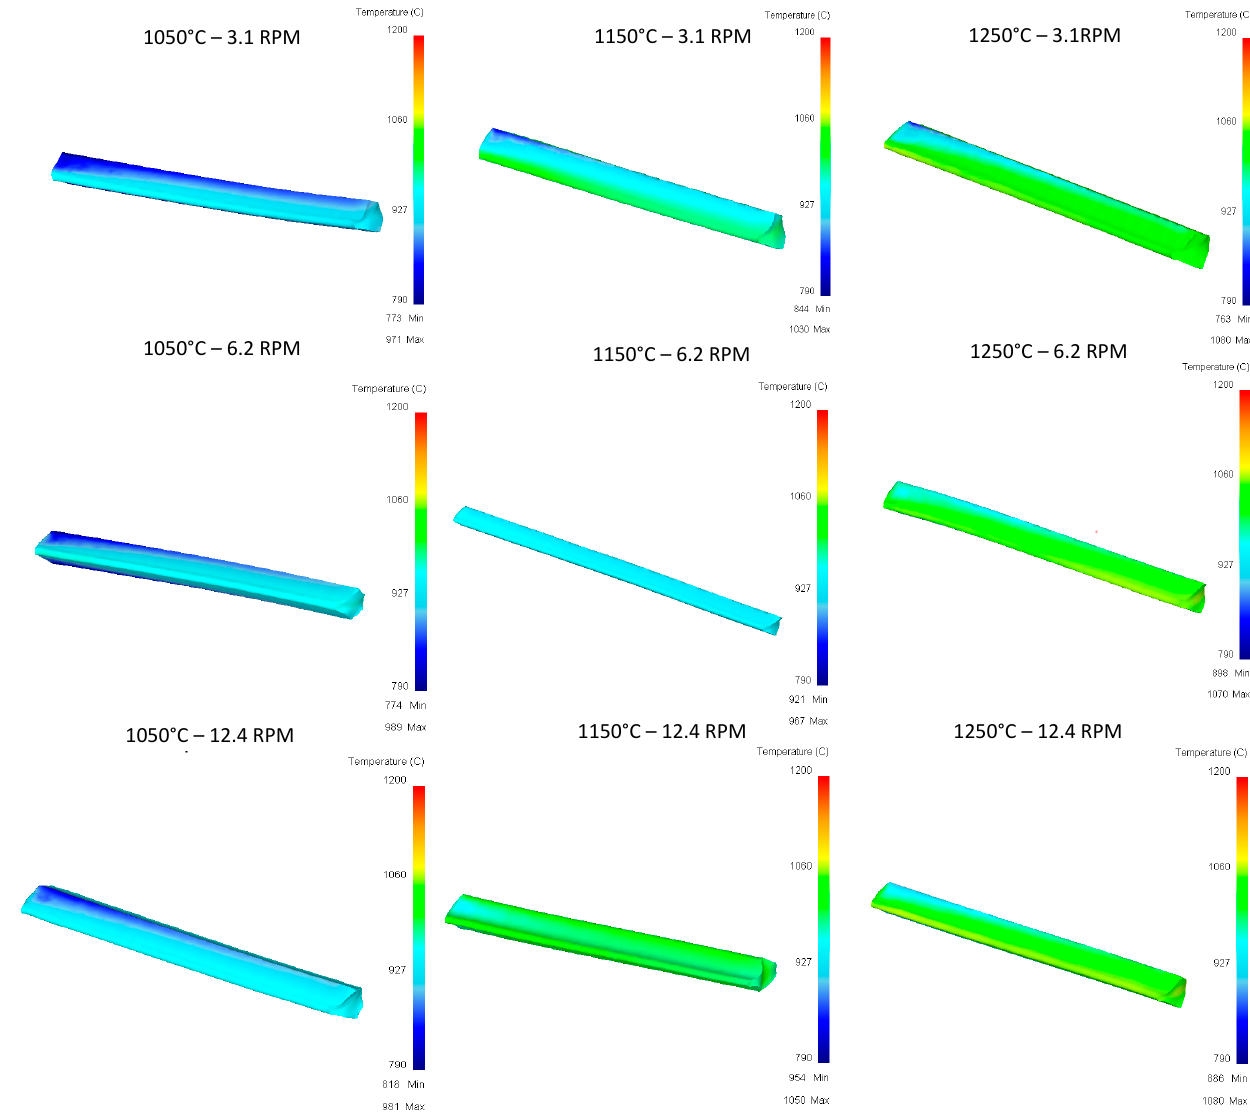
Figure 21. Upper Rail temperature graph for fourth pass.